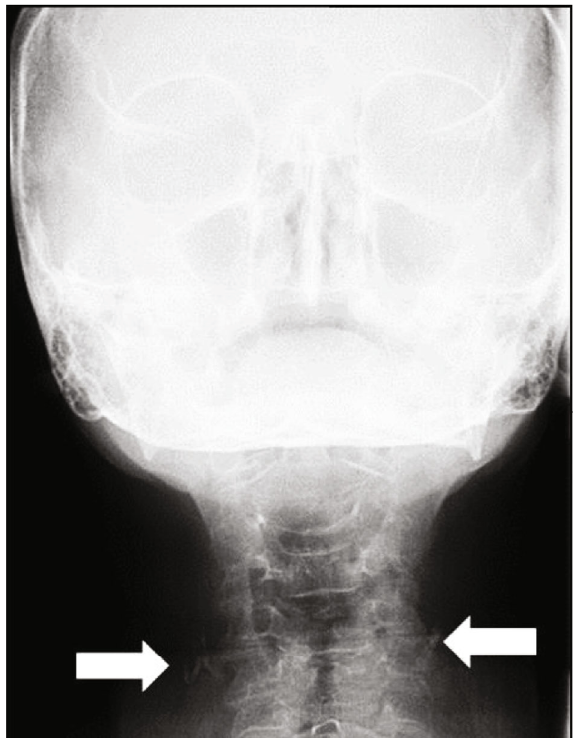
Figure 7: Manzi Projection showing the presence of bilateral radiopaque masses, adjacent to the cervical region (arrows). Notice that these structures are inferior to the calci fi ed structure region demonstrated by the panoramic radiograph.